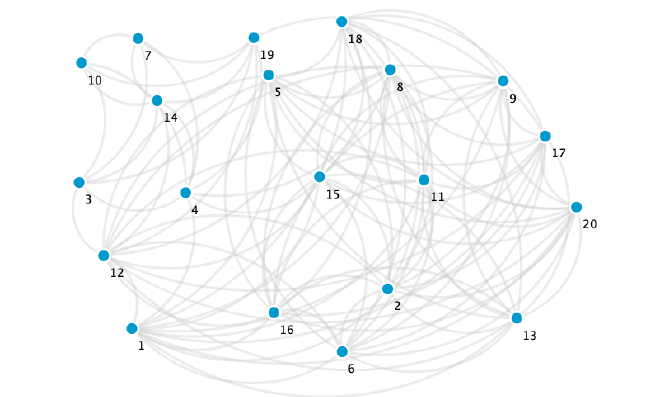
Figure 2. Graph obtained from E .